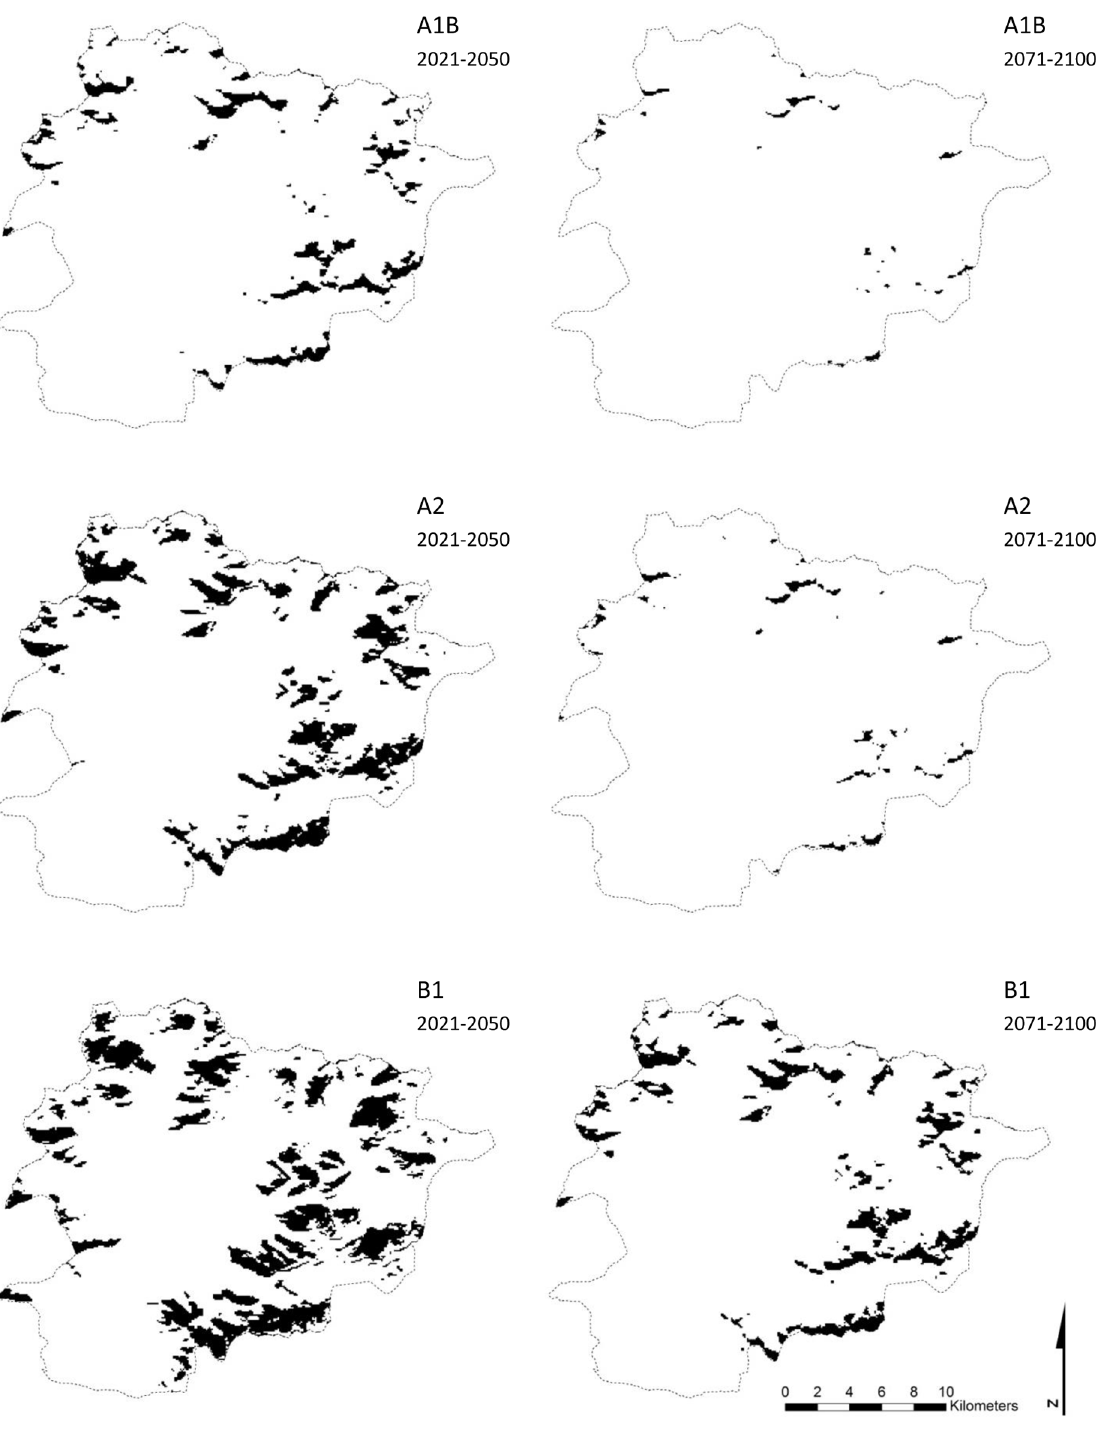
Fig 2. Rhododendron ferrugineum potential distribution under climate change. The black tone indicates predicted areas of the potential distribution of Rhododendron ferrugineum in Andorra under three climate changes scenarios (A1B, A2 and B1) for the periods 2021 – 2050 and 2071 – 2100 taken from the global model at a resolution of 90